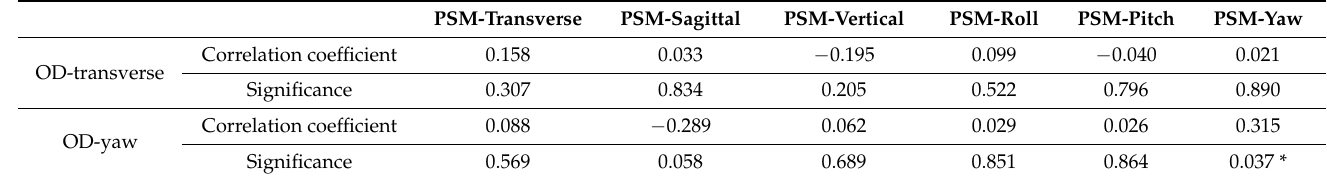
Table 2. Spearman’s correlation of PSM and OD in transverse and yaw: Spearman’s correlation revealed that the outcome discrepancy in yaw rotation had a positive relationship with planned surgical movement in yaw rotation (PSM: planned surgical movement; OD: outcome discrepancy; p = 0.05; *: statistically